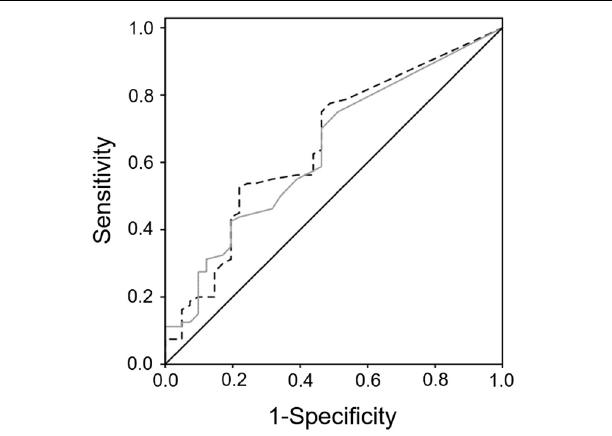
FIGURE 2 | ROC Receiver operating characteristic (ROC)-Curve analysis for successful aging discrimination. ROC curve analyses revealed that CD141 + /AV + (discontinued black line), and CD141 + /CD41 + -CD61 + /AV + (gray line) endothelial- and platelet-derived circulating microvesicles (cMV) discriminate successful and non-successful aging with an AUC (95%CI) of 0.655 (0.551, 0.758), P = 0.005, and 0.638 (0.535, 0.741) P = 0.013, respectively. Black continuous line is the reference line of the ROC curve (AUC = 0.5). AV indicates annexin V. Used markers for MV phenotyping are shown in Supplementary Table 1